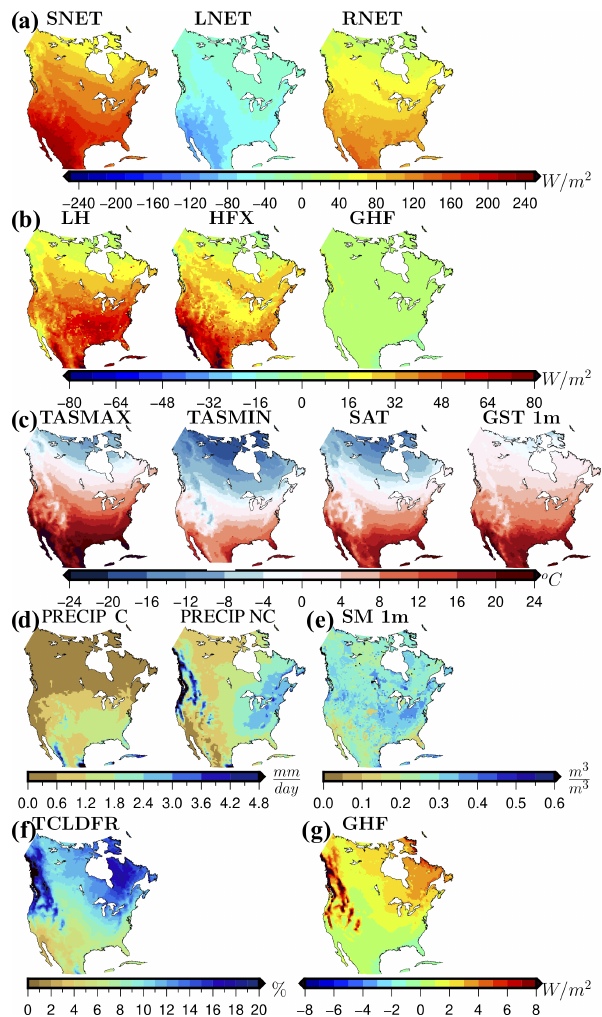
Figure 2. Ensemble mean of the LSM simulations for the sur- face energy fluxes and near-surface conditions: net shortwave radia- tion (SNET), net longwave radiation (LNET), surface net radiation (RNET) (a) ; latent heat flux (LH), sensible heat flux (HFX), ground heat flux (GHF) (b) ; maximum temperature (TASMAX), minimum temperature (TASMIN), surface air temperature (SAT), soil tem- perature at 1m depth (GST 1m) (c) ; accumulated convective and non-convective precipitation at the surface (PRECIP C and PRECIP NC) (d) ; soil moisture contained in the first soil metre (SM 1m) (e) ; and total cloud cover fraction (TCLDFR) (f) for the WRF ensem- ble mean. GHF results are also represented using its own colour scale (g) . Mean values are estimated as the temporal average for the period 1980–2013 using simulations performed with 50km resolu-